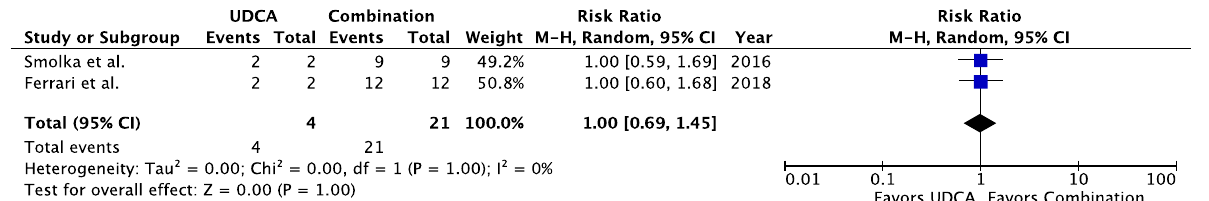
Figure 11. Transplant-free survival in ASC patients treated with combination therapy vs. UDCA. UDCA = ursodeoxycholic acid and Combination = UDCA + prednisone AZA.